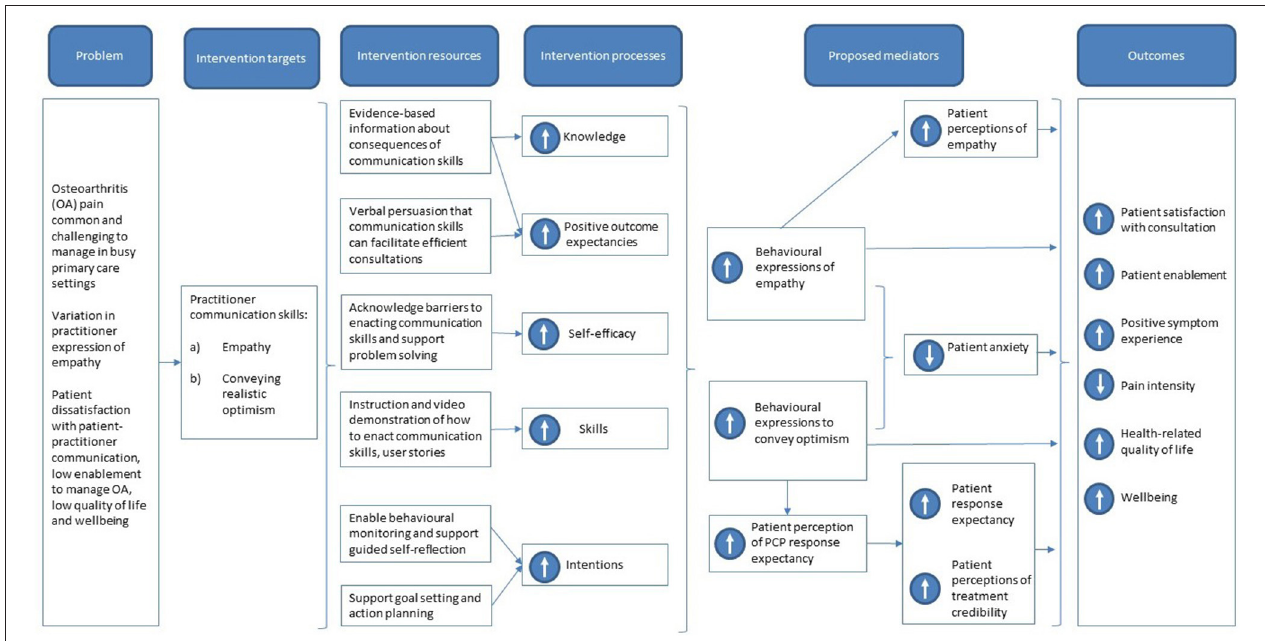
FIGURE 4 | Logic model for